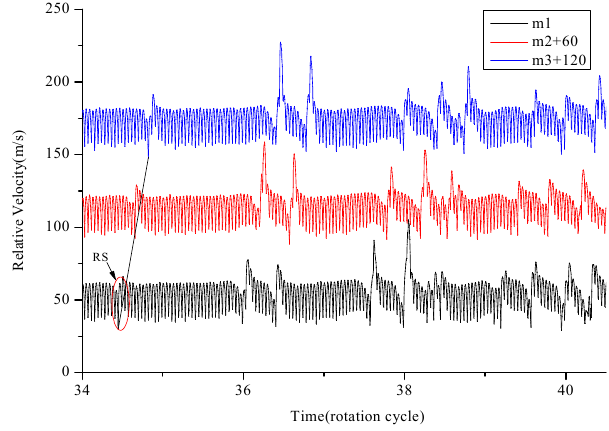
Figure 6. Relative velocities of the monitoring points.